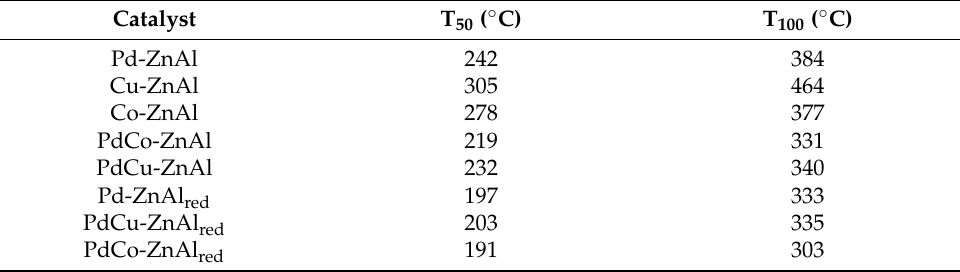
Table 4. T 50 and T 100 obtained with the studied catalysts in propene